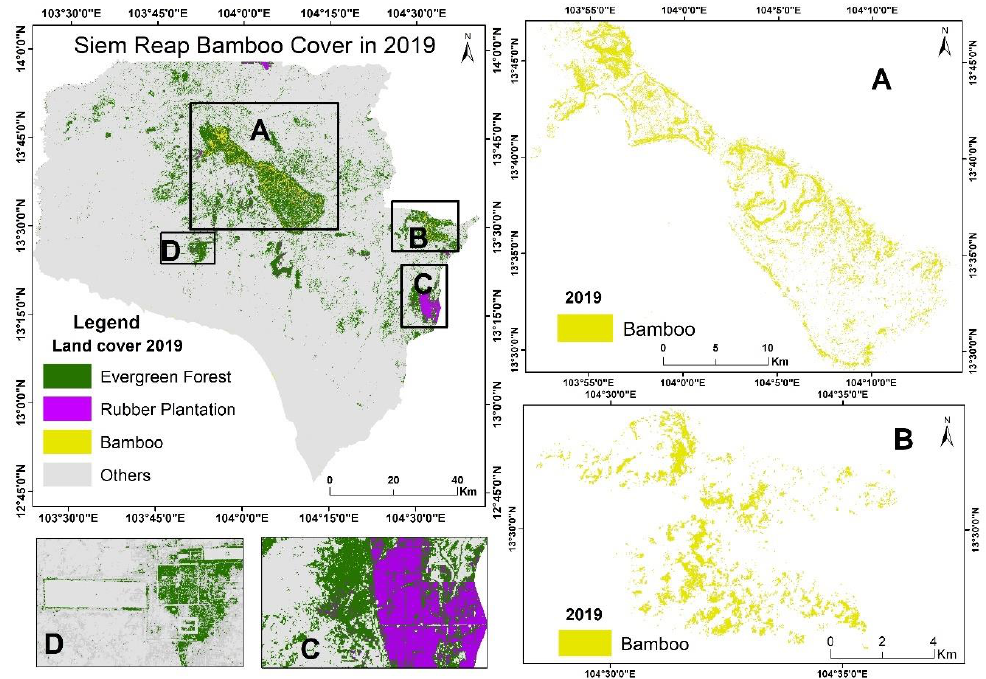
Figure 13. Maps showing the bamboo distribution using the Sentinel-2 in Siem Reap, 2019. Inset maps show natural distribution of bamboo around the Kulen Mountain ( A ) and Boeng Peae Wildlife Sanctuary areas ( B ), rubber plantation ( C ) and dense evergreen forest around the Angkor Wat temple ( D